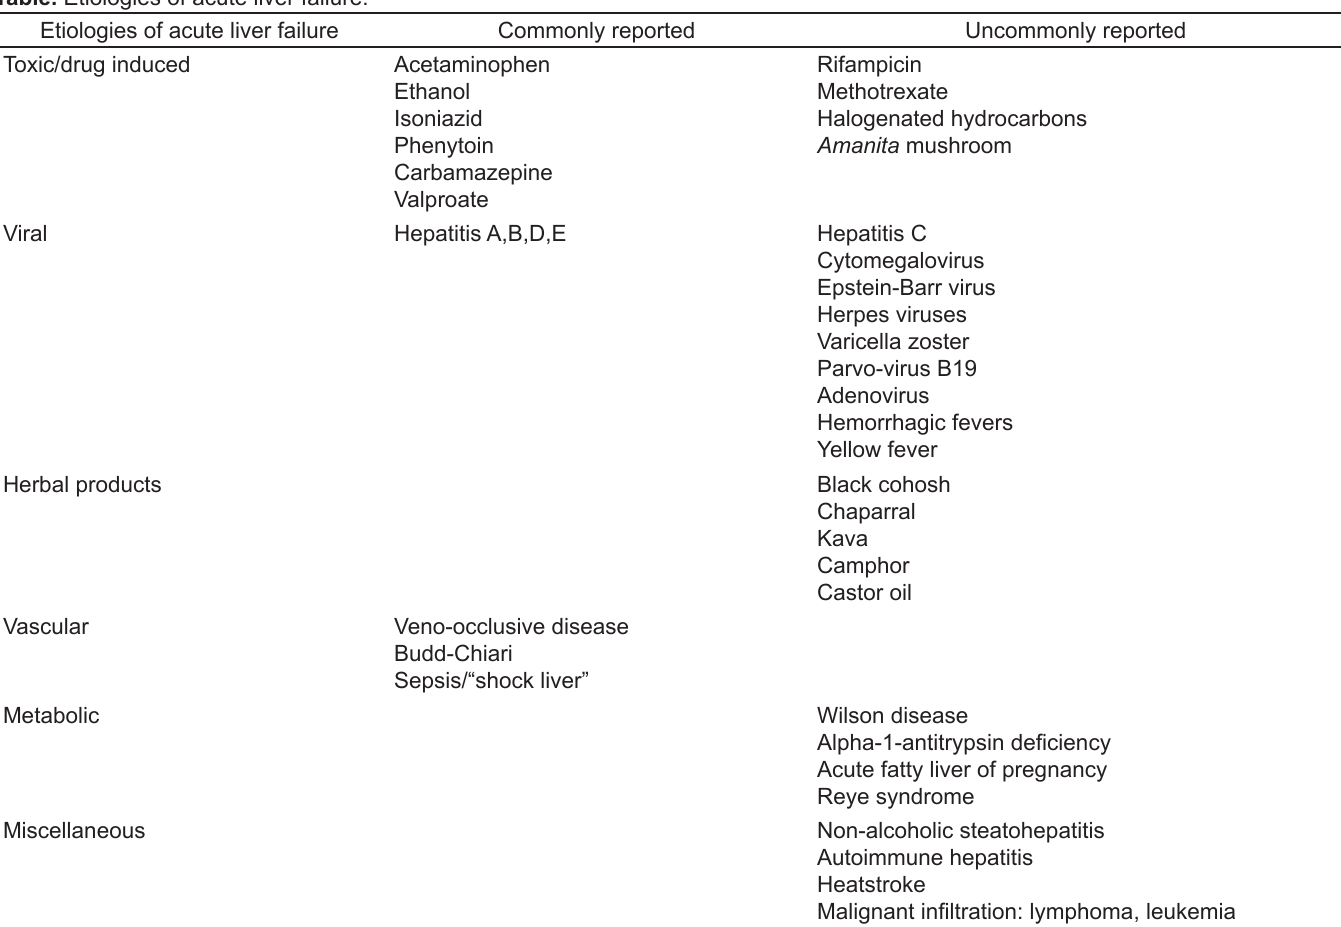
Table. Etiologies of acute liver